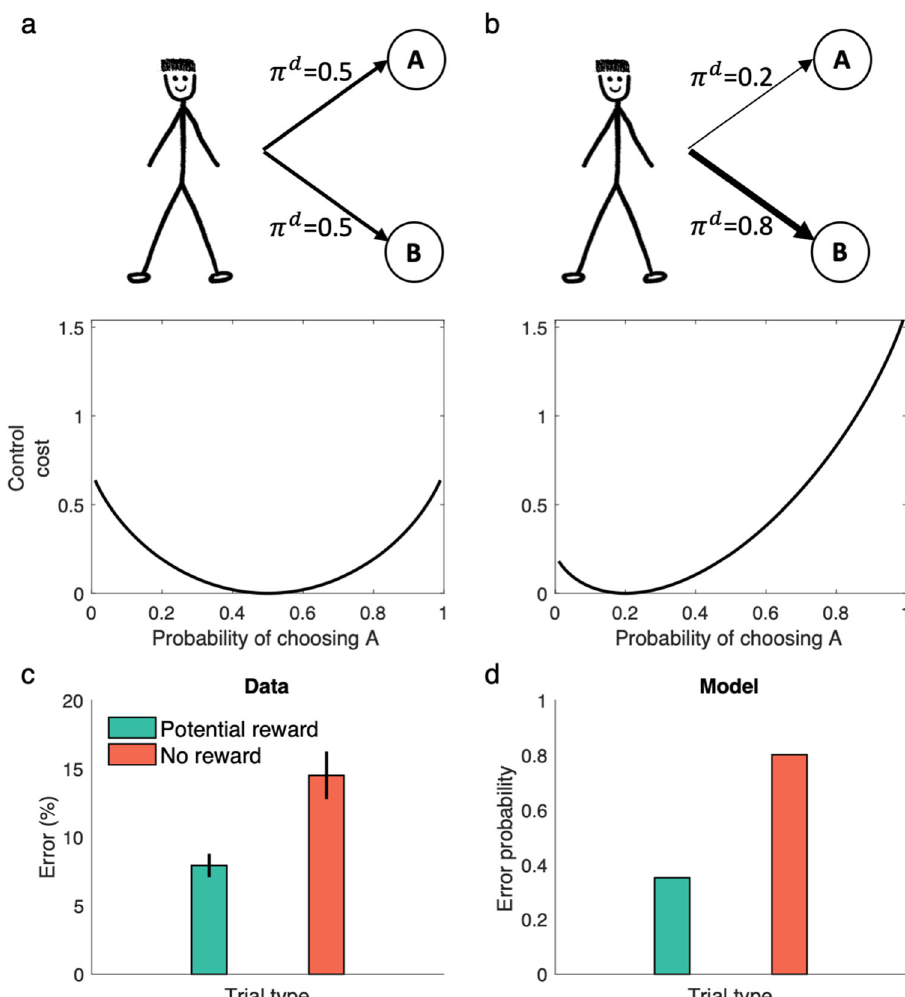
Fig. 8 Linear RL captures prepotent actions and costs of cognitive control. a , b The control cost is plotted as a function of the decision policy. For a uniform distribution ( a ) as the default policy, the control cost is a symmetric function of the decision policy. When the default policy is skewed toward a more likely response ( b ), the control cost is higher for reliably performing the action that is more unlikely under the default. c People show classical Stroop effect in a color-naming Stroop task in which the name of colors are printed in the same or different color. These errors, however, are reduced in potential reward trials, in which correct response is associated with monetary reward 51 . d The linear RL model shows the same behavior, because the default probability is larger for the automatic response (i.e. word reading). Promising reward reduces this effect because the agent balances expected reward against the control cost to determine the optimized policy. Data in ( c ) are adapted from Krebs et al. 51 , in which mean and standard error of the mean are plotted (obtained over n = 20 independent samples). Source data are provided as a Source Data fi